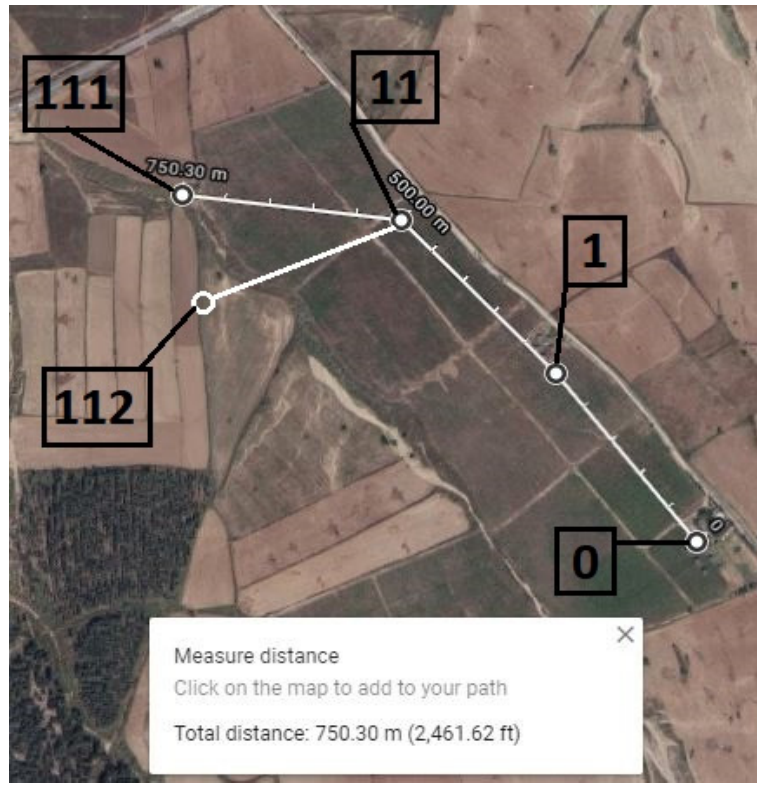
Figure 11. Multi-hope communication distance map.